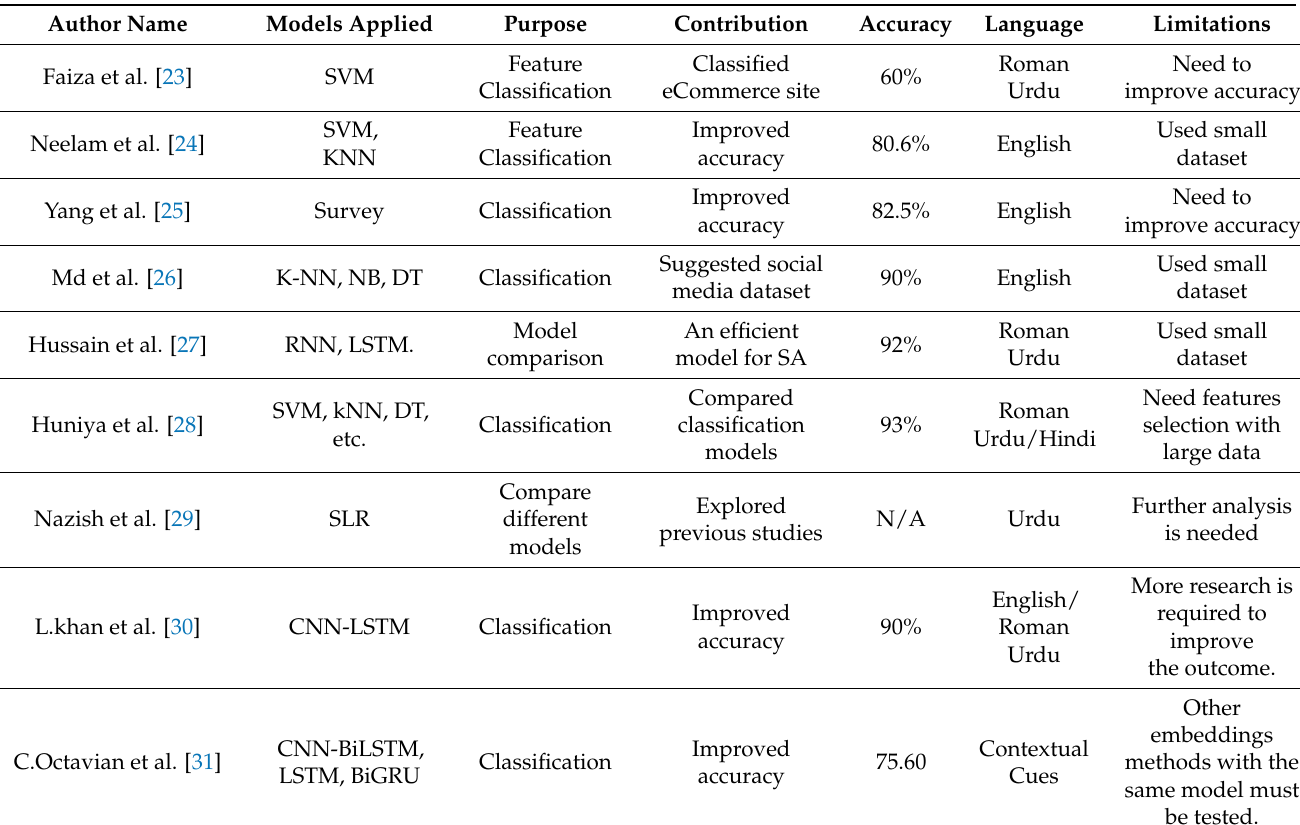
Table 2. Sentiment Analysis Previous Literature